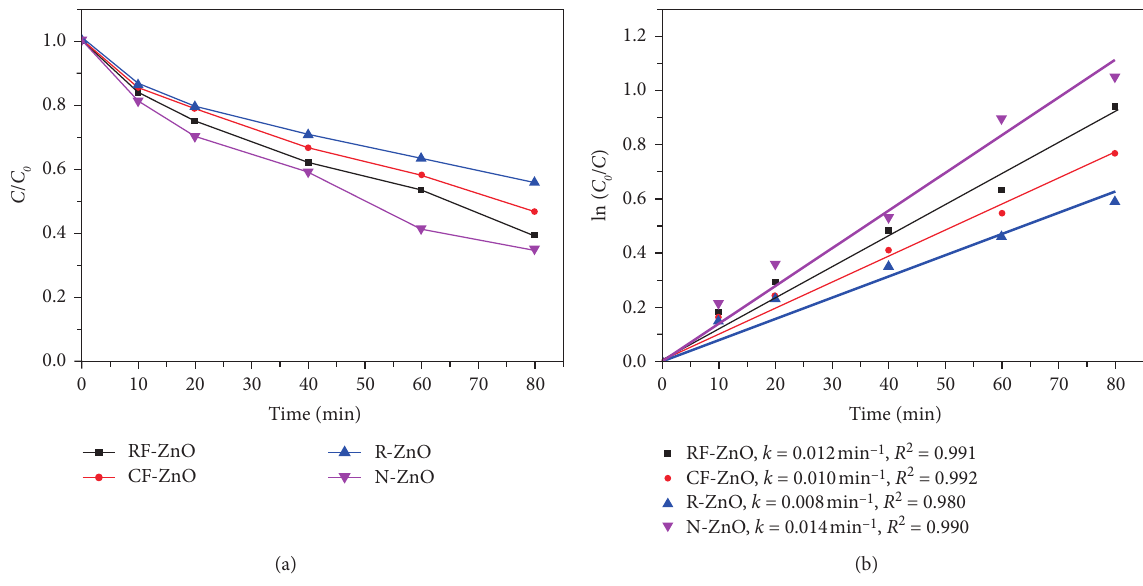
Figure 7: Photodegradation of caffeine in as-prepared samples and (b) the kinetic curves. The reaction conditions: dosage catalyst 0.5g/L, CAF concentration of 20 mg/L, and pH � 6.0.